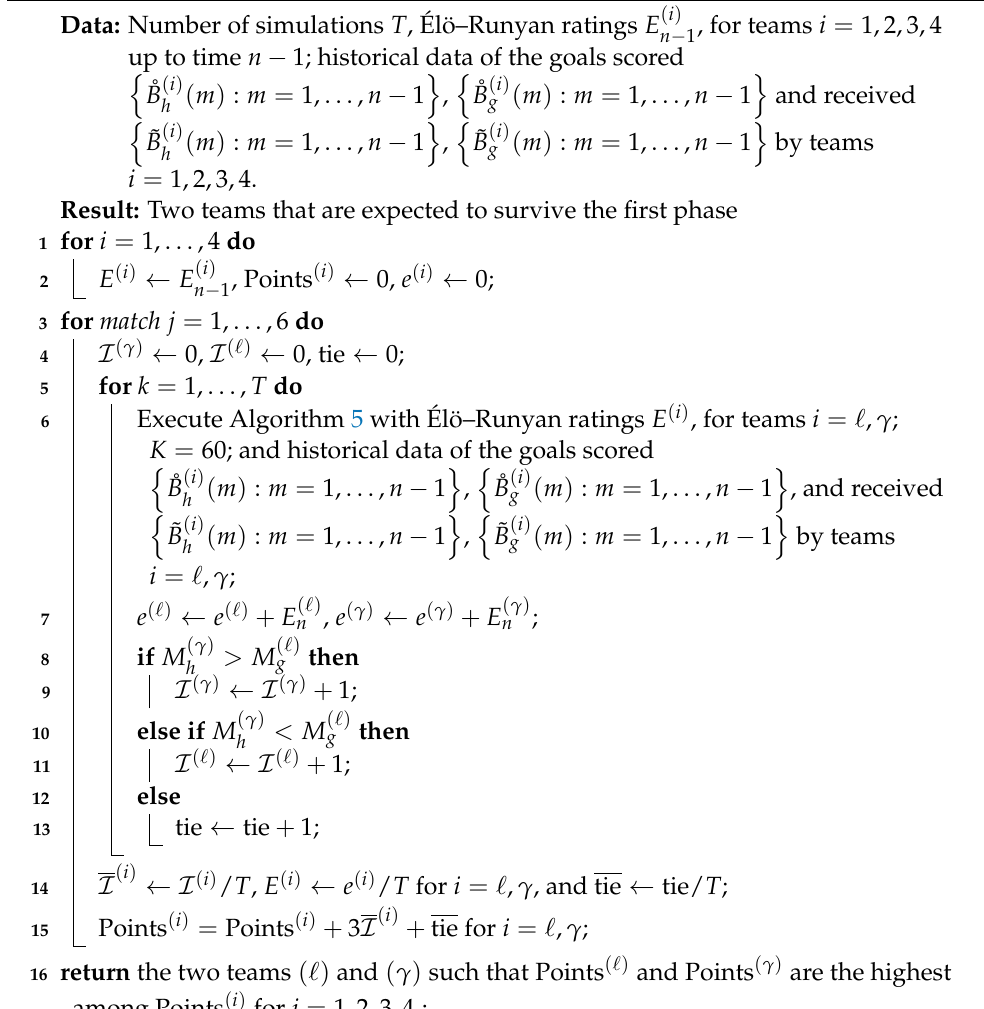
Algorithm 6: Results of the first phase for a Word Cup